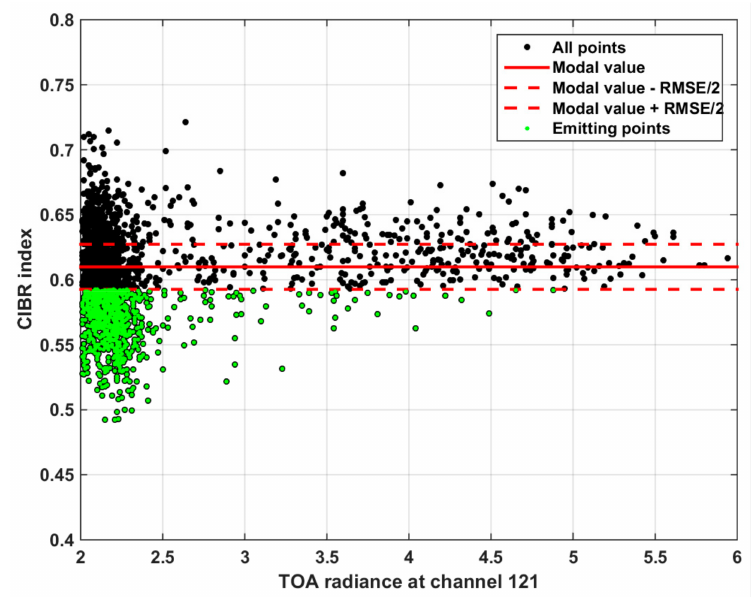
Figure 9. Distribution of CIBR values for TOA 121 greater than 2 Wm − 2 sr − 1 µ m − 1 (LUSI case study).